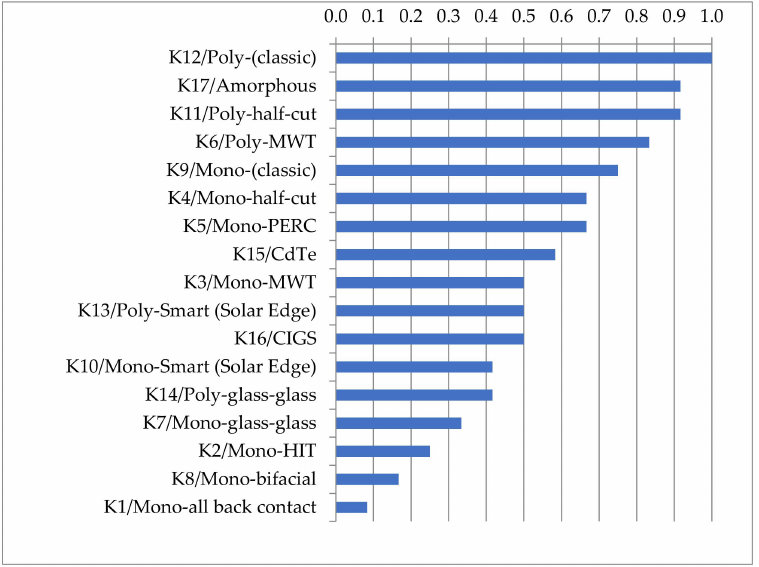
Figure 4. Visualization of the ranking of photovoltaic panel technology types based on “Option 3”